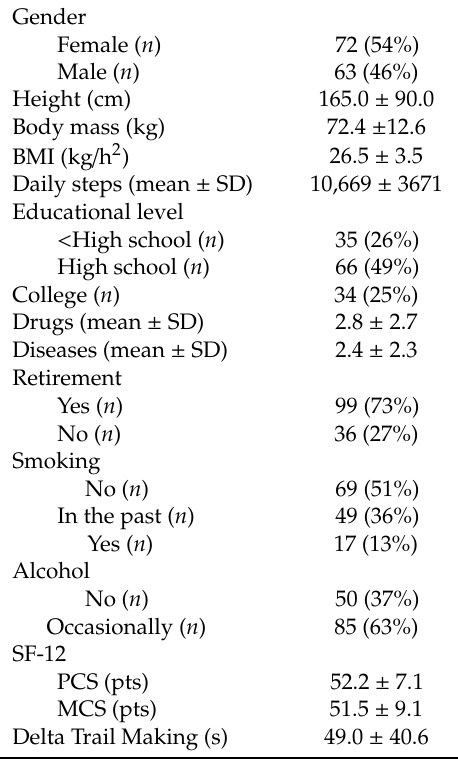
Table 1. Participant characteristics: gender, anthropometric data, physical activity (number of daily steps), education, number of medications and diseases, retirement, smoking, and alcohol habits, mean values of summary scores of the Short Form Health Survey 12 SF12 for physical (PCS) and mental (MCS) health perception and executive function (Delta Trail Making).